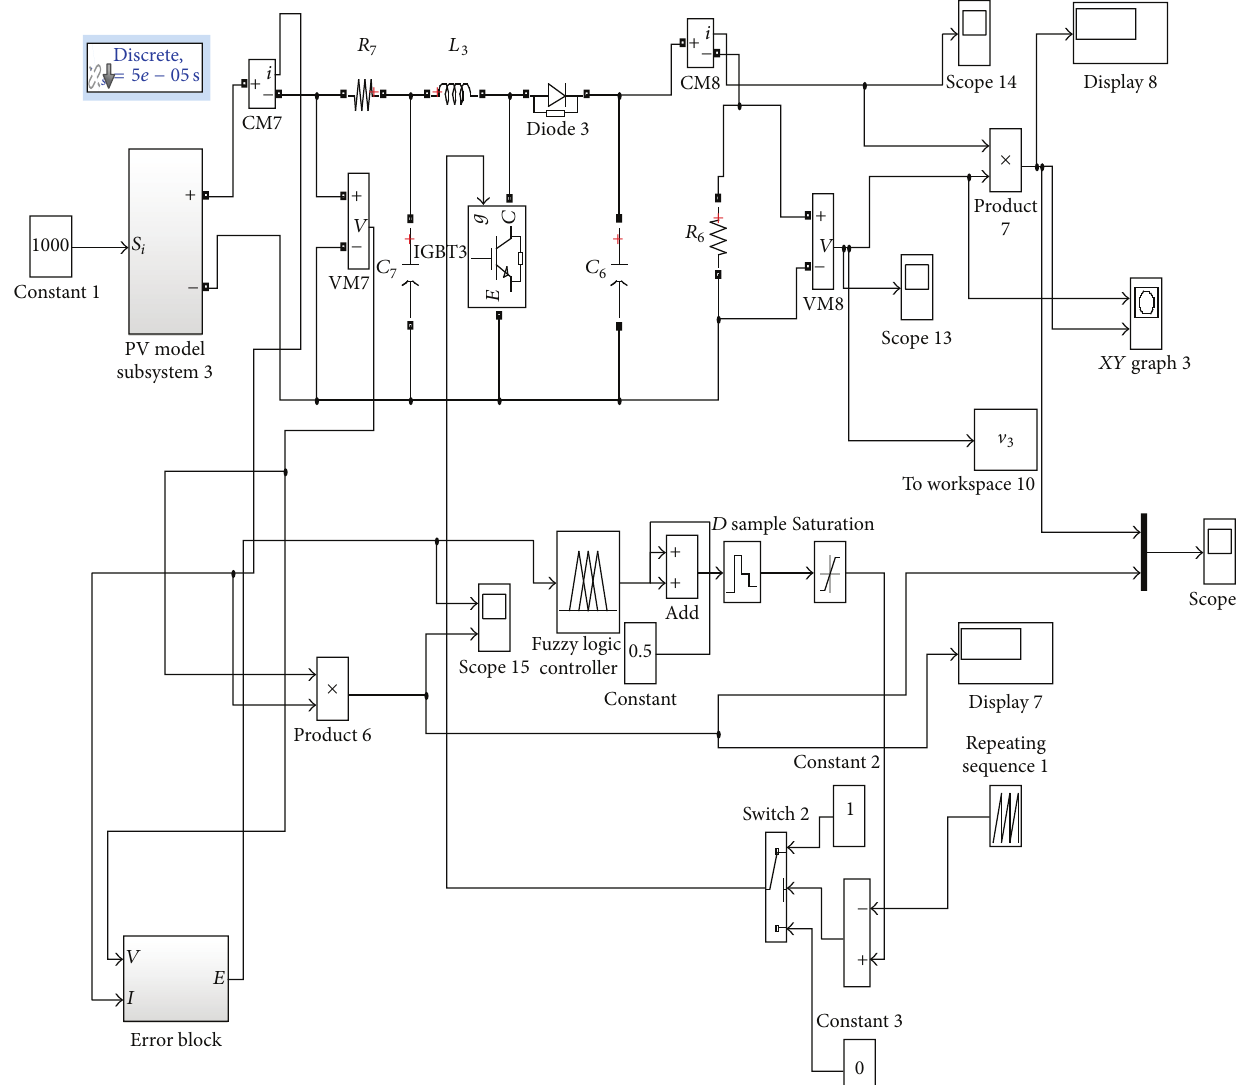
Figure 8: Simulink model for fuzzy logic controller based boost